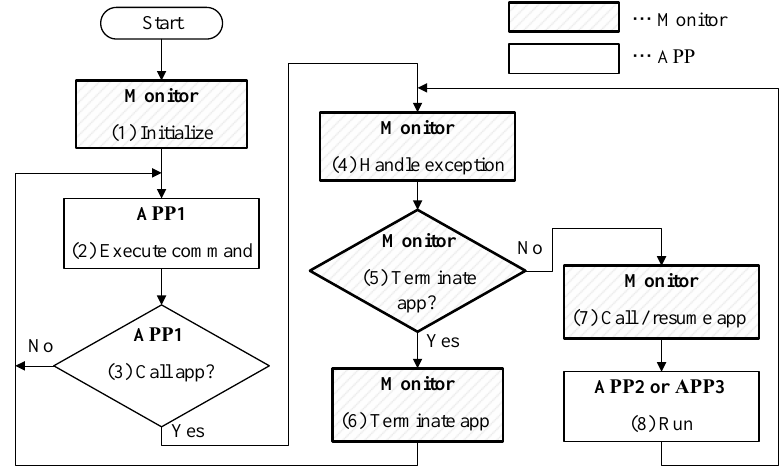
Figure 6: Flowchart of PoC TEE describing context switch handled by the